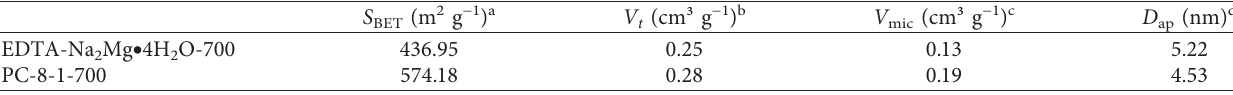
• 4H 2 O-700. • 4H 2 Mg 2